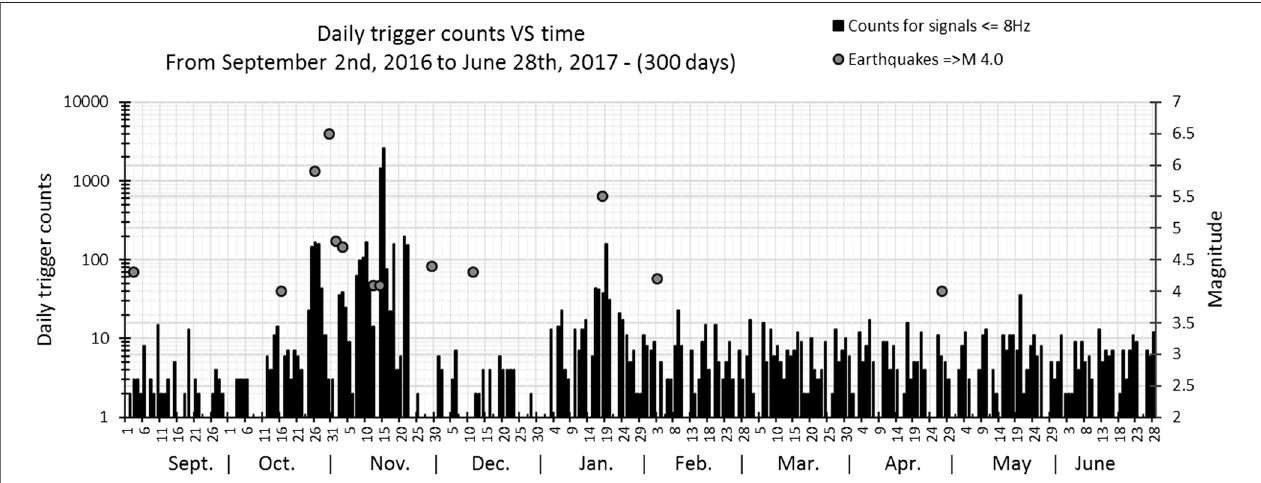
FIGURE 6 | Two signi fi cant increases of the daily counting rate below 8 Hz were recorded, the fi rst from 25 October to 23 November and then another that appearedfrom16to20January.Noticethattheplotreportsonlythebiggestdailyearthquakeslistedin Table1 .Theplotreportsonlythedailybiggestearthquakeslisted in Table 1 by gray